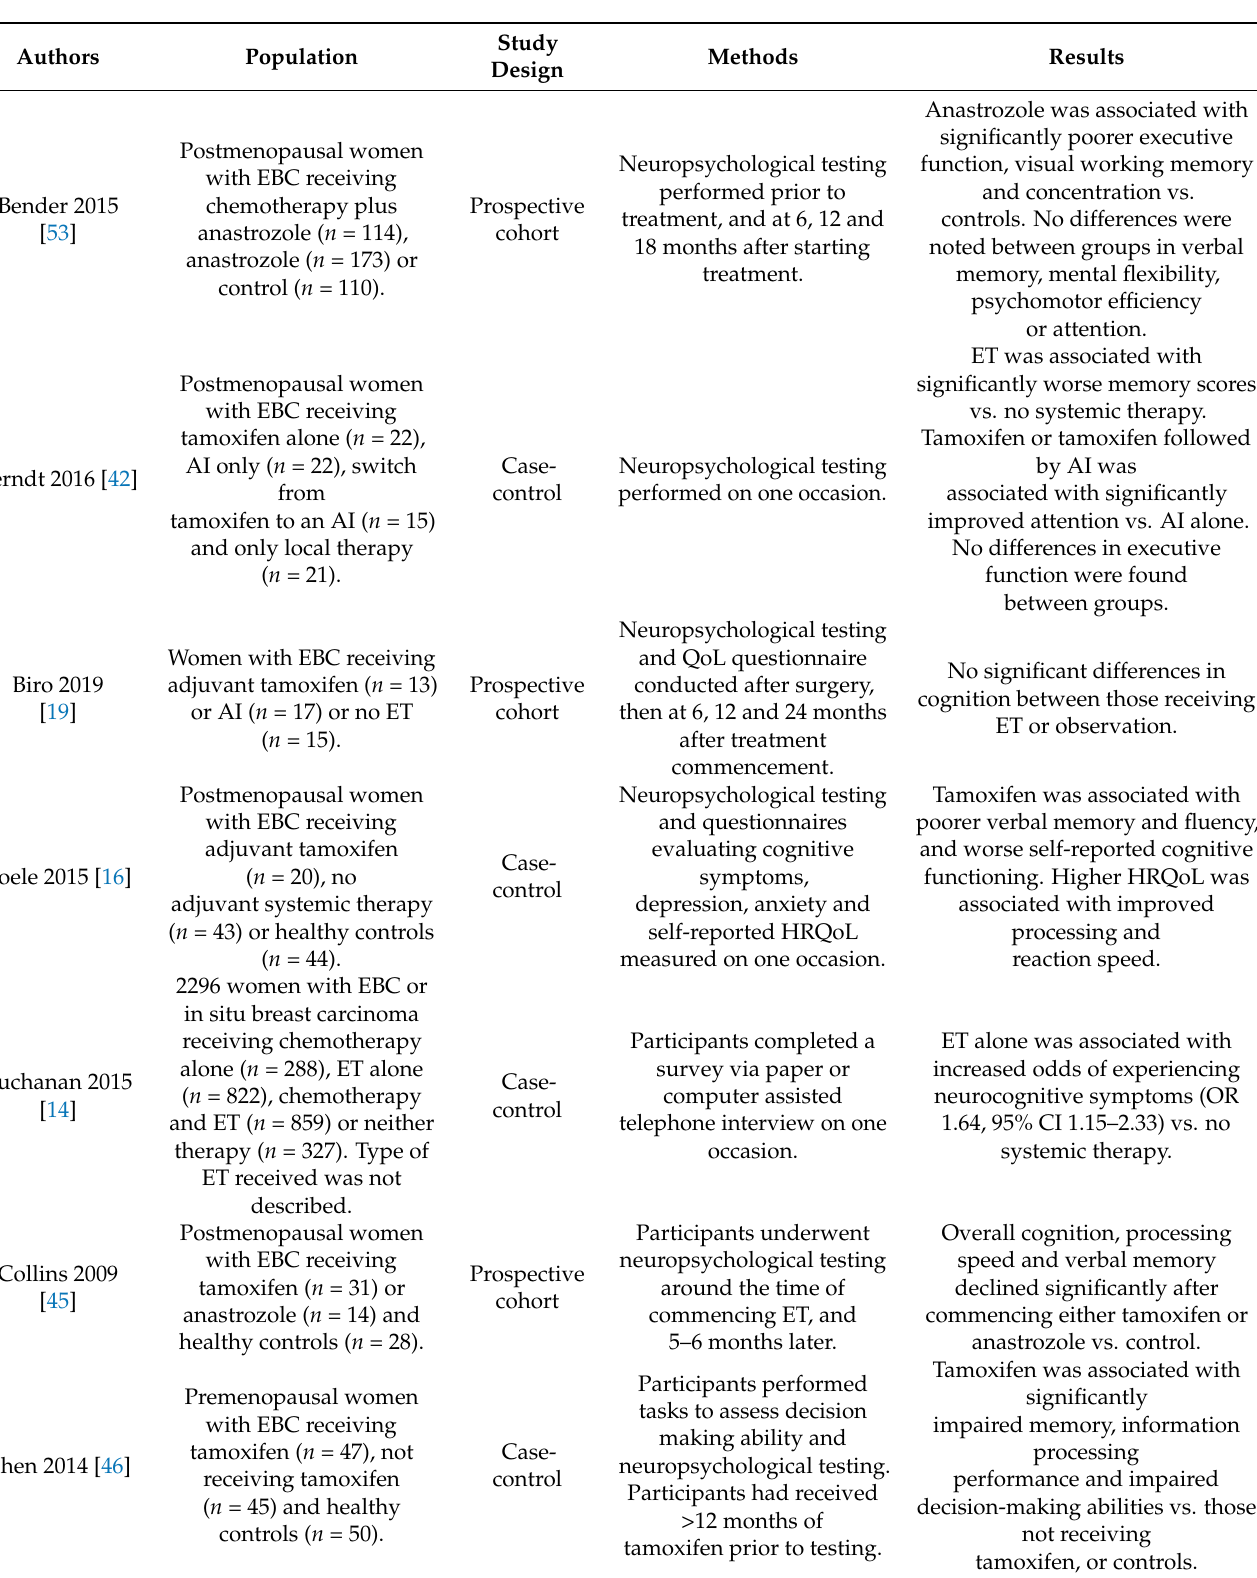
Table 1. Studies of the impact of endocrine therapy on cognition in women at high risk of breast cancer, with invasive breast cancer or breast carcinoma in